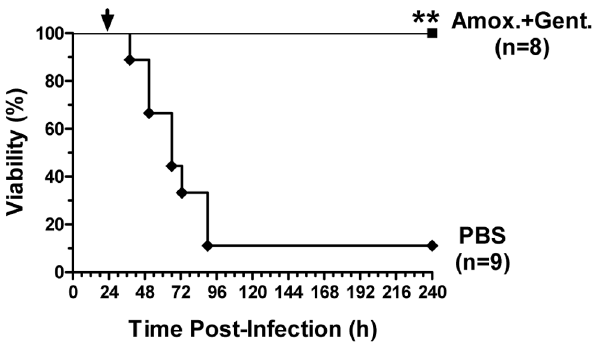
Figure 7. Delayed antibiotic treatment prevents lethality in murine gastrointestinal anthrax. A/J mice were infected via gavage with 1.2 6 10 9 CFU of vegetative BaS. Twenty four hours later, the infected mice were treated with amoxicillin and gentamicin or PBS alone for 3 consecutive days. Mice were followed for 10 days post infection. **P , 0.01. The p value represents the significance of the difference in survival between the antibiotic treatment and PBS control groups, calculated using the log-rank (Mantel-Cox)